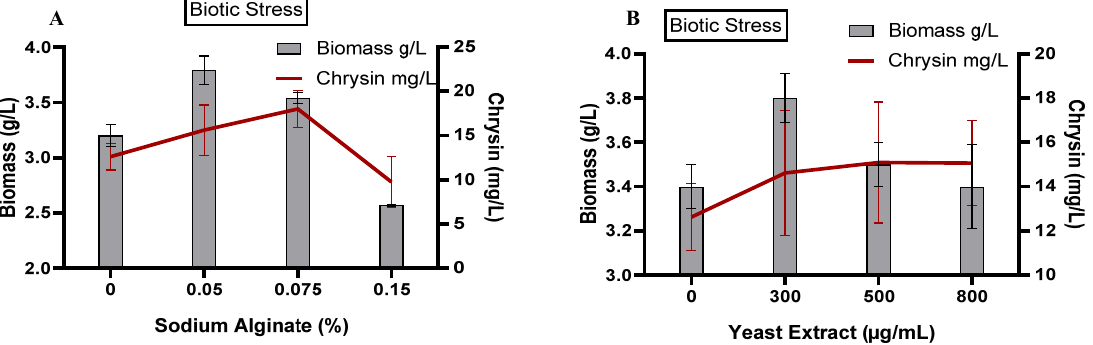
Figure 3. Effect of biotic elicitors on C. globosum biomass and production of chrysin. ( A ) Sodium alginate (NaAlg); ( B ) Yeast extract (YE).